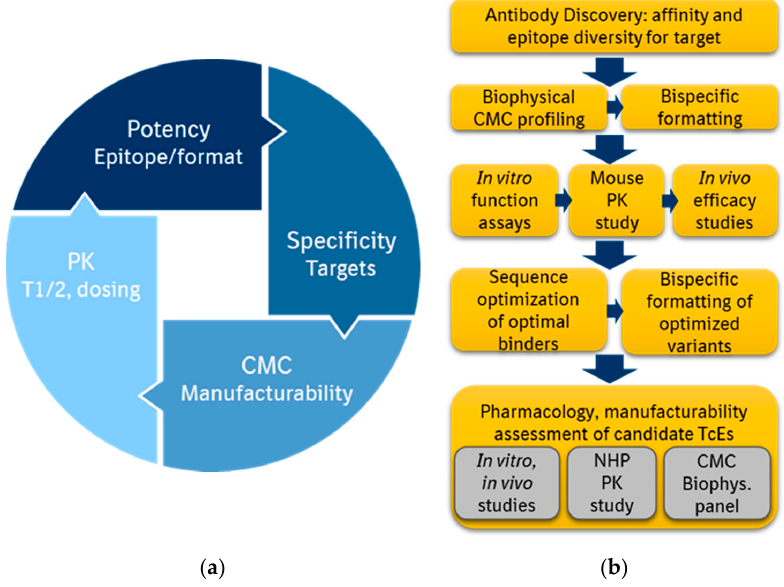
Figure 3. T-cell Engagers in drug discovery: ( a ) Optimal features in a half-life extended Next-Gen T-cell Engager. First generation TcEs such as BiTEs show very high potency, but very short half-life, and challenging manufacturability. Current half-life extended TcEs aim to show strong potency, similar to BiTEs, while also featuring manufacturability and PK properties similar to regular IgG biologics; ( b ) Proposed workflow for drug discovery of T-cell Engagers. Discovery of antibodies with diverse a ffi nity and epitopes to the target is beneficial, especially of novel targets. Side-by-side function and stability profiling are recommended before and after sequence-optimization, because of the interdependent importance of both Pharmacology and CMC for the clinical success of a TcE.